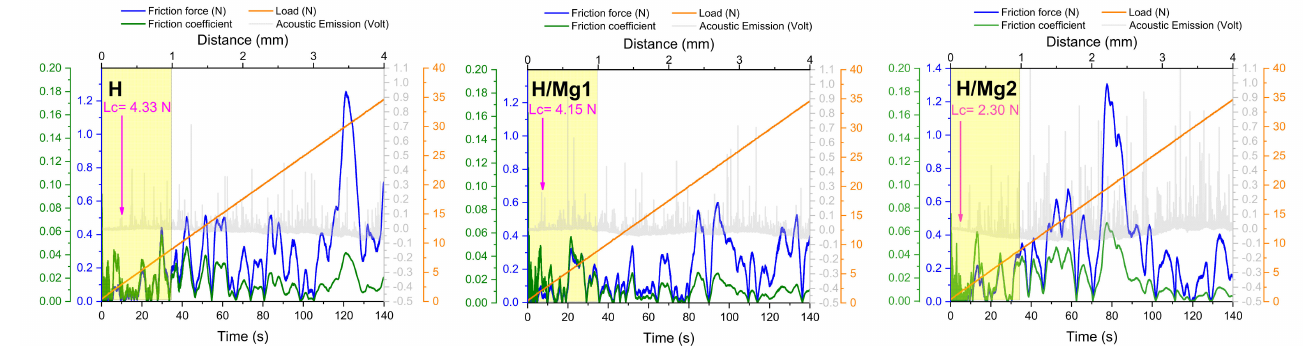
Figure 9. Scratch curves for all investigated coatings obtained by micro-scratch tests.